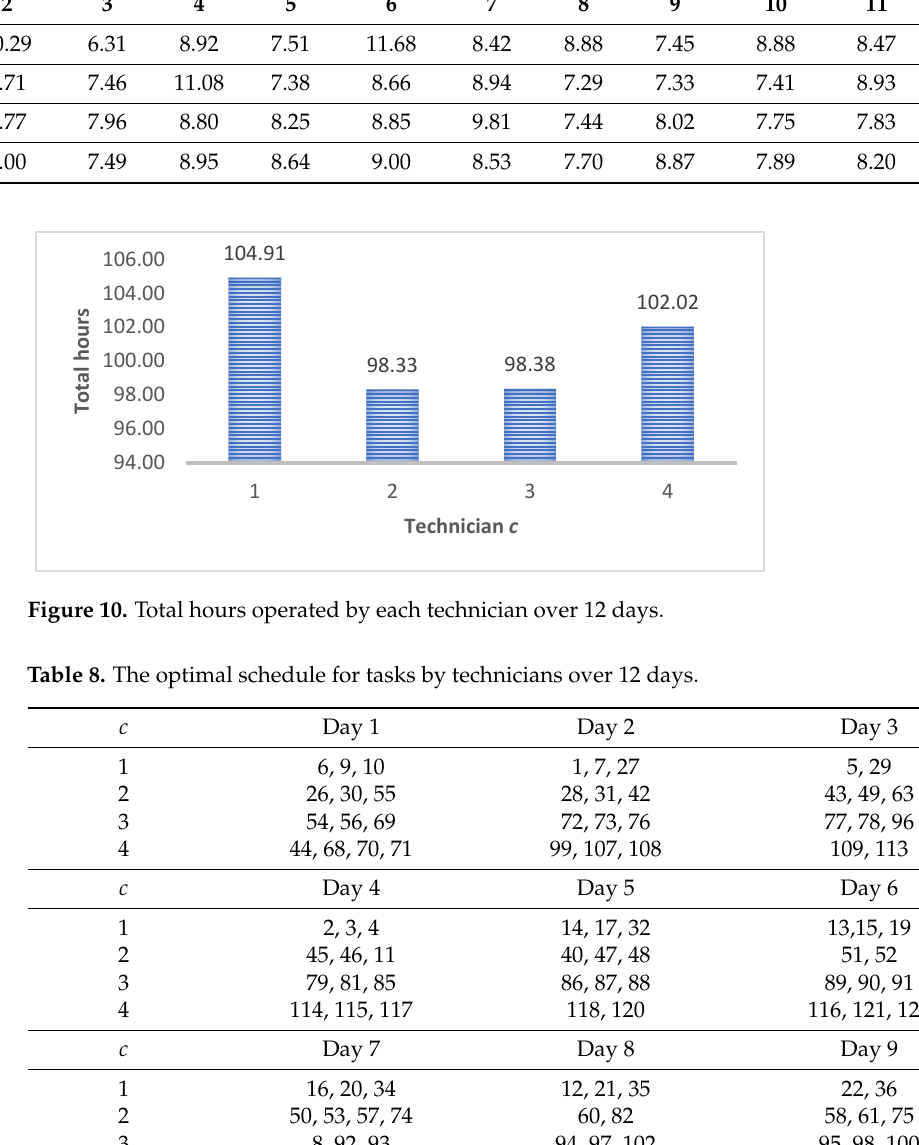
Table 7. The operated durations by each technician in all days (hours).